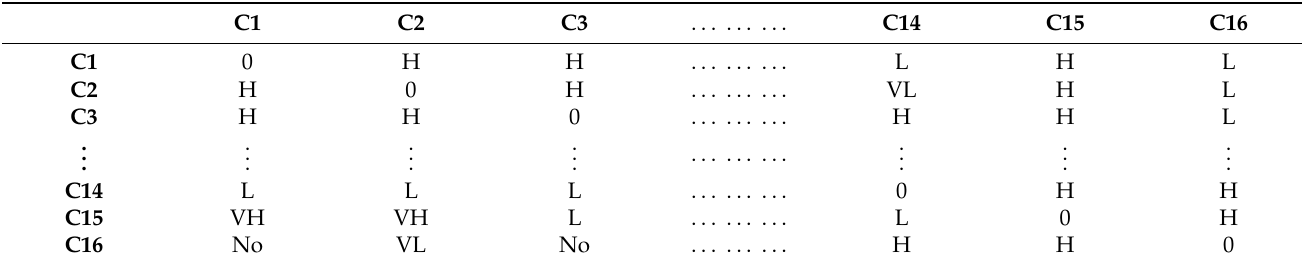
Table 3. Assessment from an expert in linguistic terms.